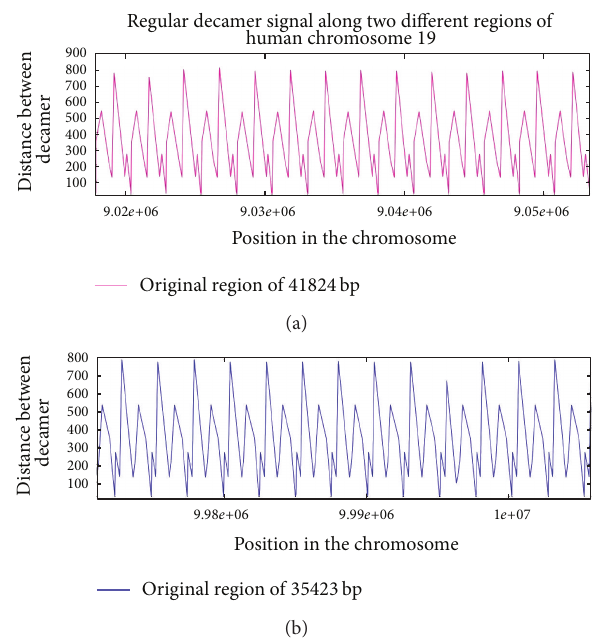
Figure 11: Plot of the distances between the generic decamer (ordinate) along two regions of chromosome 19 (abscissa) of Homo sapiens . Note the inverted repeat